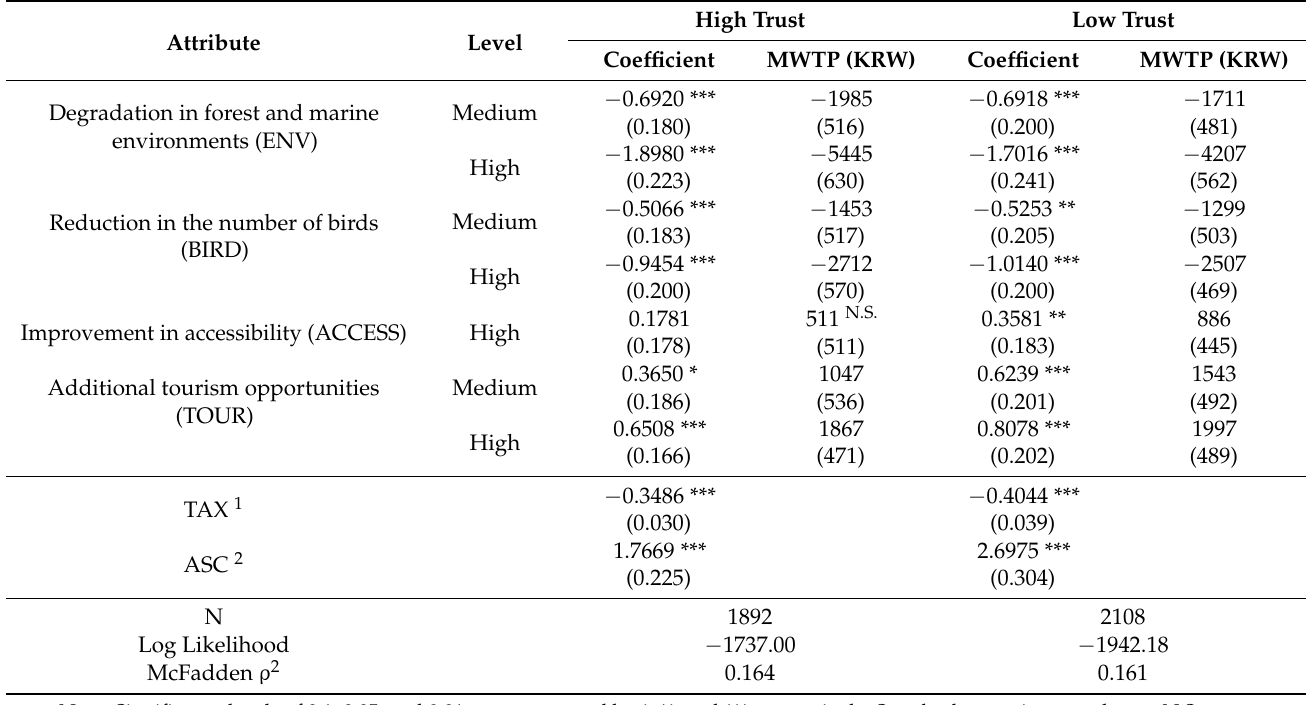
Table 5. Results of the random parameter logit model (trust in